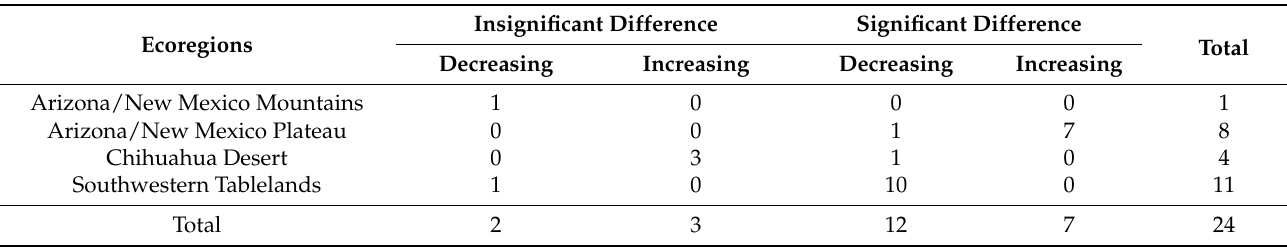
Table A3. The percentages of the randomly selected grassland pixels with respect to their significance in the difference in mean productivity before and after the break years based on the RPMS data along with their identified direction of change over the major ecoregions in New Mexico.